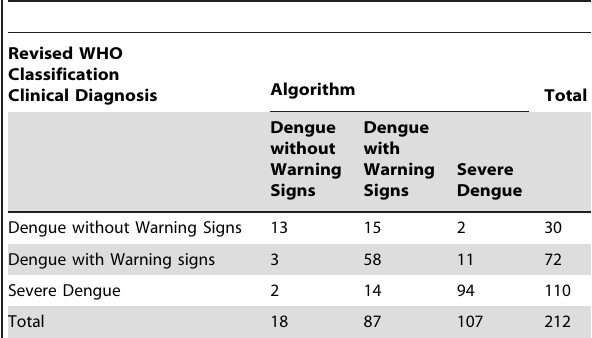
Table 7. Concordance a between clinical diagnosis and diagonsis by computer algorithm according to the revised WHO classification.